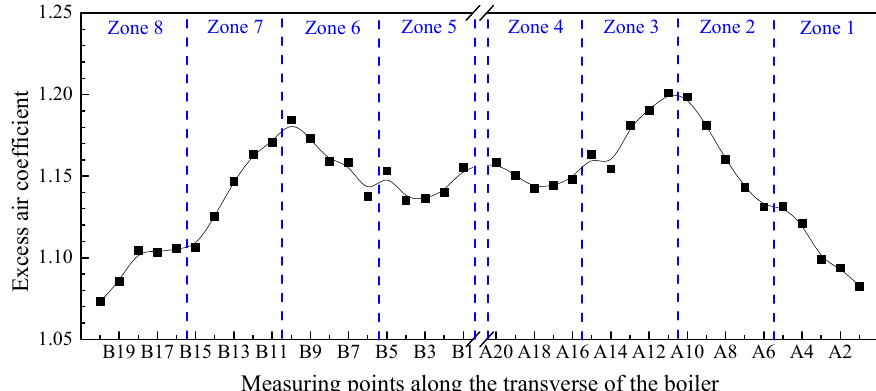
Figure 6. Excess air coefficient distribution along the width direction of the boiler.